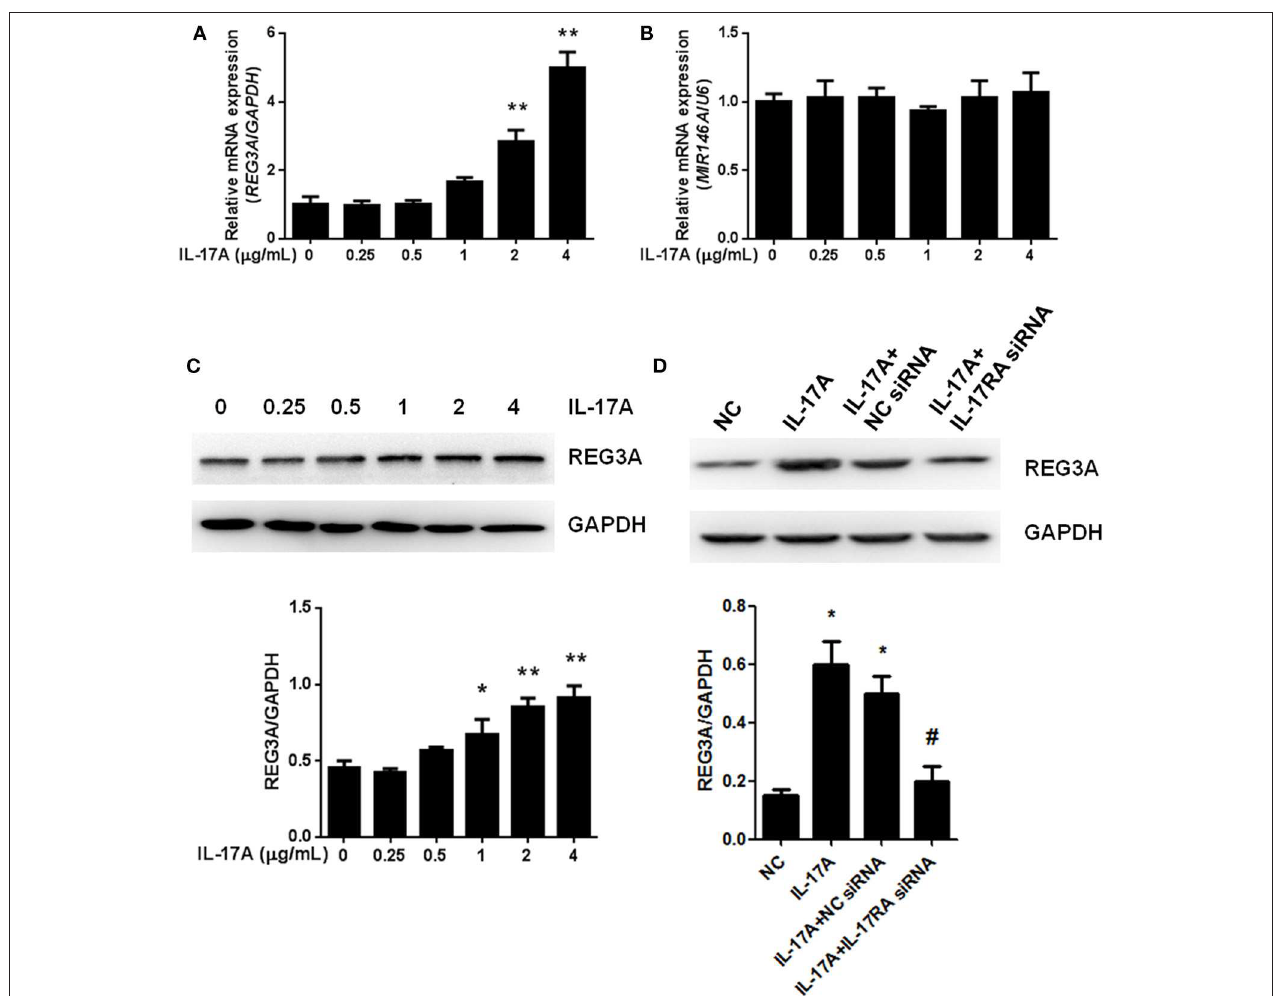
FIGURE 4 | Interleukin (IL)-17A induced regenerating islet-derived protein 3-alpha (REG3A) expression in macrophage. (A) Monocyte-derived macrophages from the peripheral blood mononuclear cells (PBMCs) of the healthy donors ( n = 3) were treated with the different concentrations of IL-17A for 24h. The messenger RNA (mRNA) expression of REG3A was determined by real-time PCR. Glyceraldehyde 3-phosphate dehydrogenase (GAPDH) was used as the internal controls. (B) Monocyte-derived macrophages from the PBMCs of the healthy donors ( n = 3) were treated with the different concentrations of IL-17A for 24h. The mRNA expression of miR-146a was determined by real-time PCR. U6 was used as the internal controls. (C) Monocyte-derived macrophages from the PBMCs of the healthy donors ( n = 3) were treated with the different concentrations of IL-17A for 24h. The protein levels of REG3A were determined by Western blot. GAPDH was used as the internal controls. (D) Monocyte-derived macrophages were transfected with the NC small-interfering RNA (siRNA) and IL-17RA siRNA in the absence or presence of IL-17A for 24h. The protein levels of REG3A were determined by Western blot. GAPDH was used as the internal controls. Western blot bands were quantified using ImageJ and normalized to GAPDH. Data are shown as means ± SEM of three independent experiment. * p < 0.05, ** p < 0.01 in comparison with the control group. # p < 0.05 in comparison with IL-17A + NC siRNA